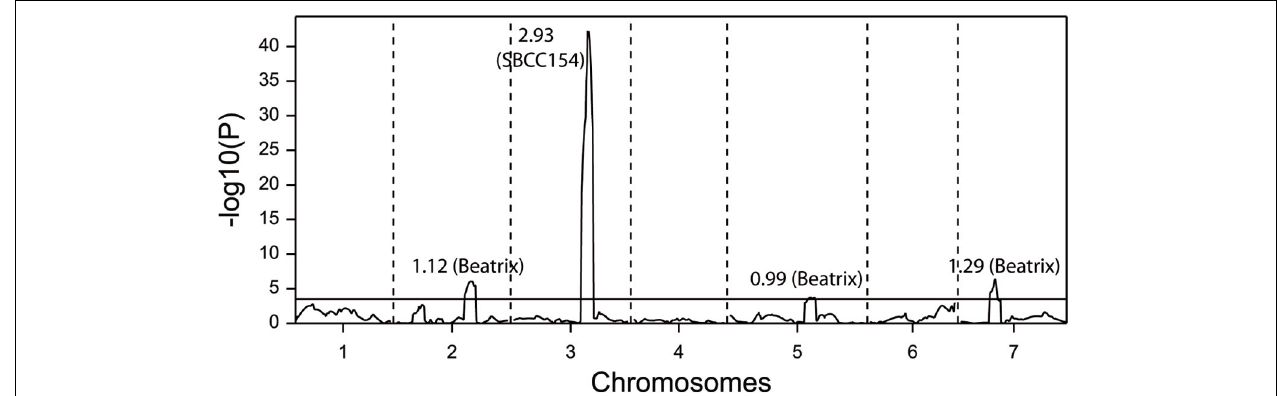
FIGURE 4 | QTL scan for flowering time at a field trial for a population of 168 doubled haploid lines from the cross SBCC154 x Beatrix. The figures besides the QTL peaks indicate the size of the effect, with the early allele indicated in